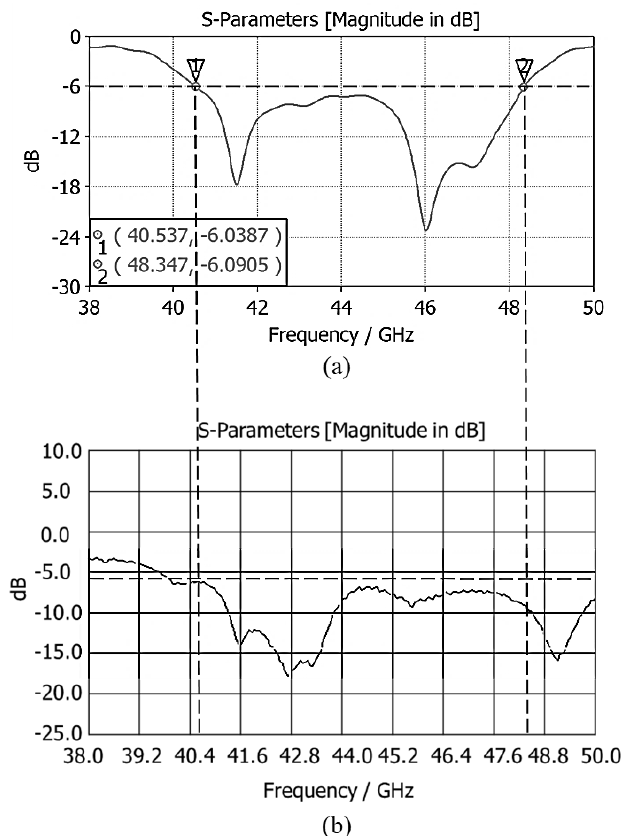
Figure 3. S-parameters (S11) of the proposed array antenna. ( a ) Simulated S-parameters. ( b ) Tested S-parameters.